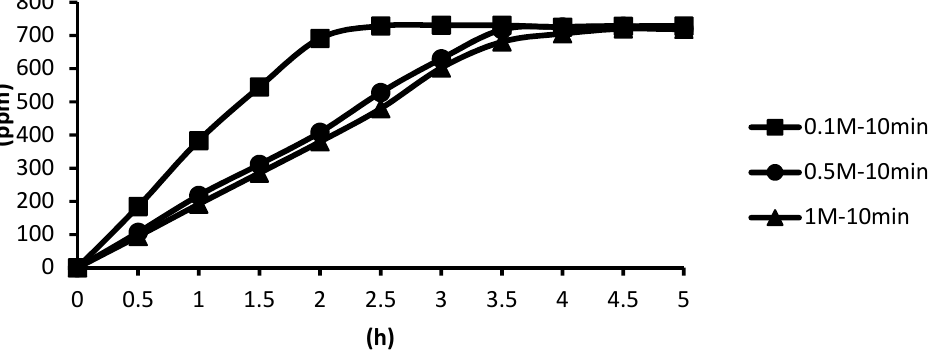
Figure 20. The effect of CaCl 2 concentration (cross-linking time of ten minutes) on releasing of tea tree essential oil from alginate/tea tree essential oil microcapsules in the hot spring water.